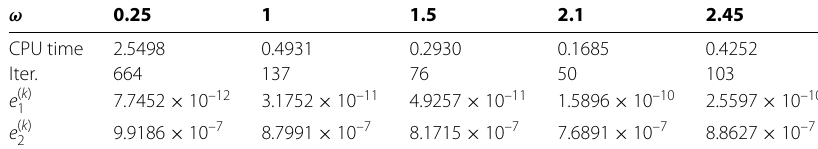
and e ( k ) for different values of ω 1 2